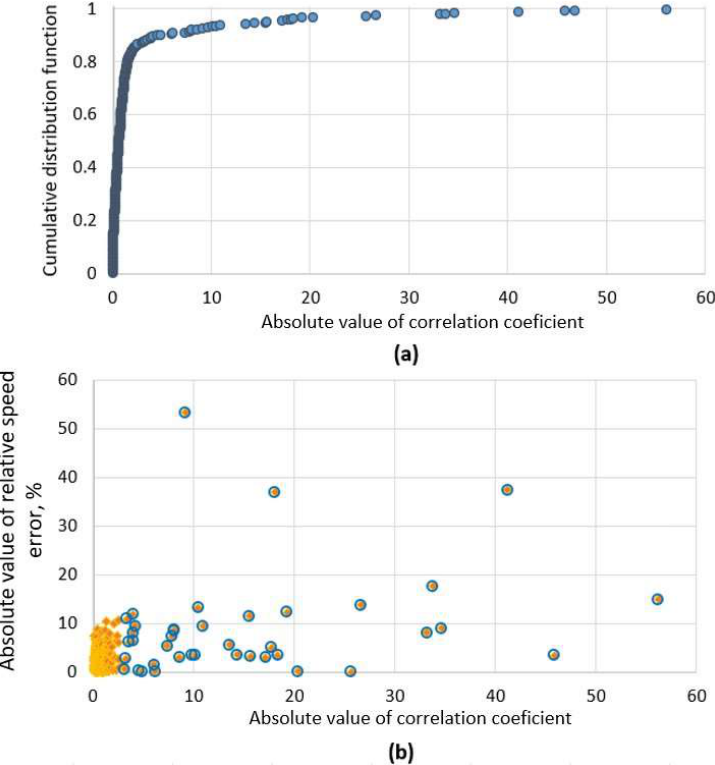
Figure 4. Top ( a ): cumulative distribution function of correlation significance coefficient for a dataset of 300 cases. Bottom ( b ): absolute value of relative speed error versus correlation significance coefficient. Cases with highly distorted signals are marked with blue circles, while regular signatures are orange.